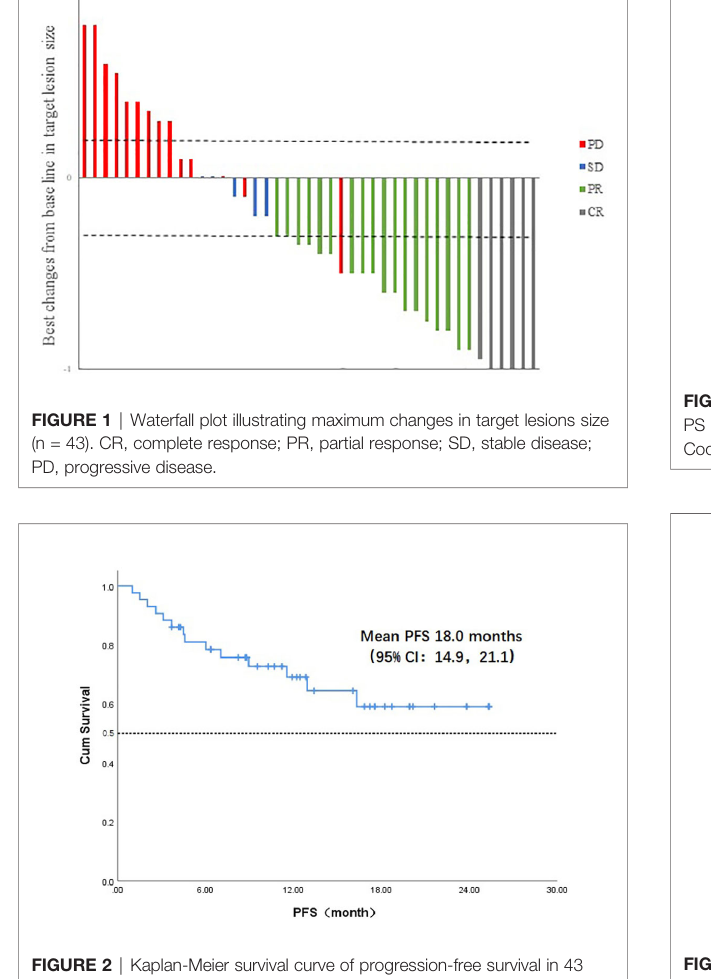
FIGURE 2 | Kaplan-Meier survival curve of progression-free survival in 43 head and neck cancer patients. PFS, progression-free survival;CI, con fi dence interval.